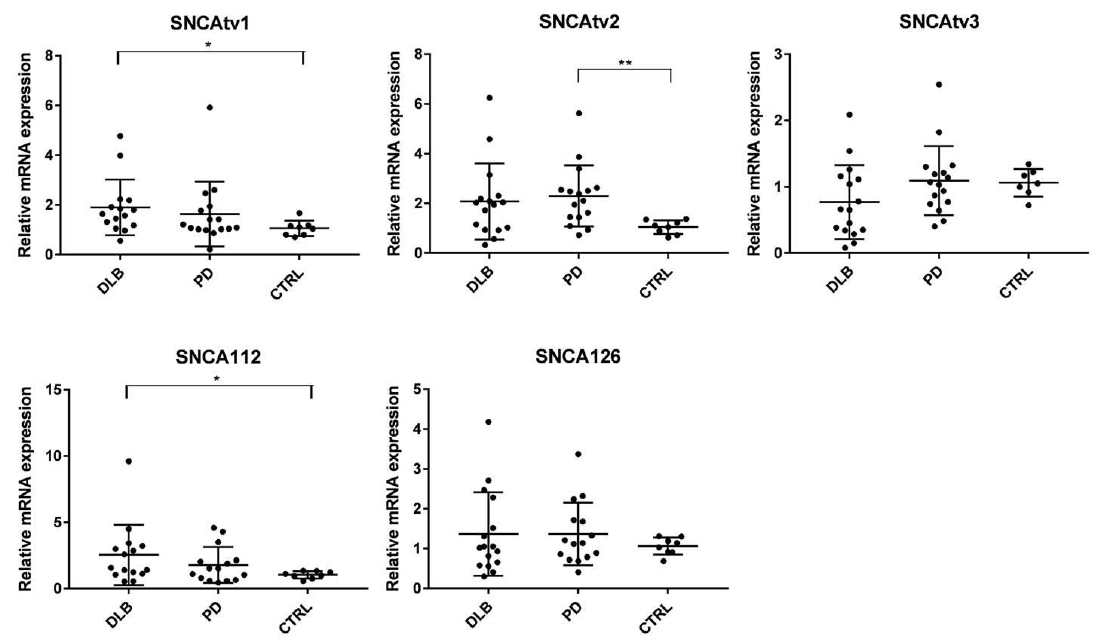
Figure 1. Expression of SNCA transcript variants in the temporal cortex of DLB and PD patients and controls. * p < 0.05, ** p < 0.01.